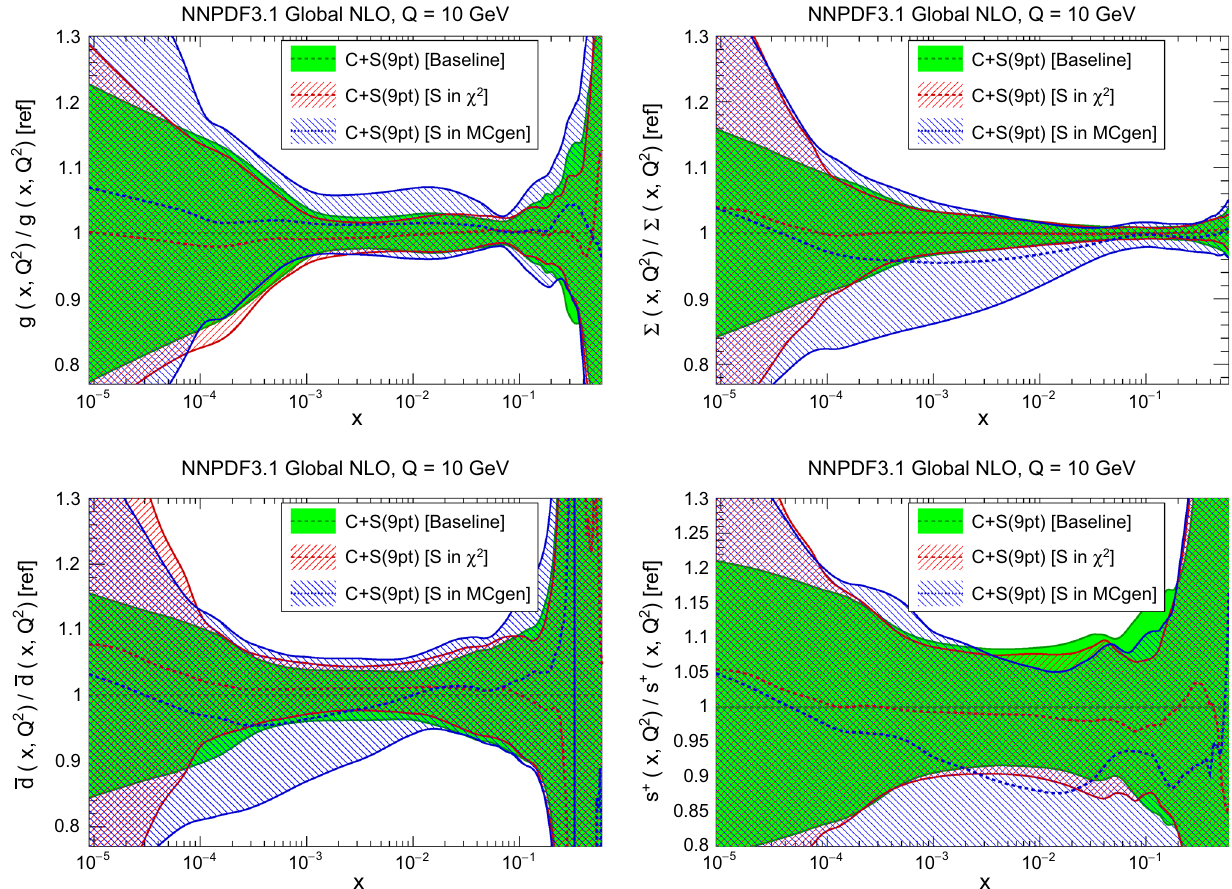
Fig. 20 Same as Fig. 16, now comparing the results of the baseline C + S ( 9pt ) fit with those in which the theory covariance matrix S is included either in the χ 2 definition or in the generation of Monte Carlo replicas, but not in both Table 9 The total cross-sections for Higgs production in gluon fusion (in pb) obtained by using NLO global PDFs based on either C or C + S ( 9pt ) , see Table 5. We quote the central prediction, the total PDF uncertainty (first) and the MHOU uncertainty on the hard cross-section (second) expressed as a percentage of the central value. The latter is Higgs production in gluon fusion at 13 TeV